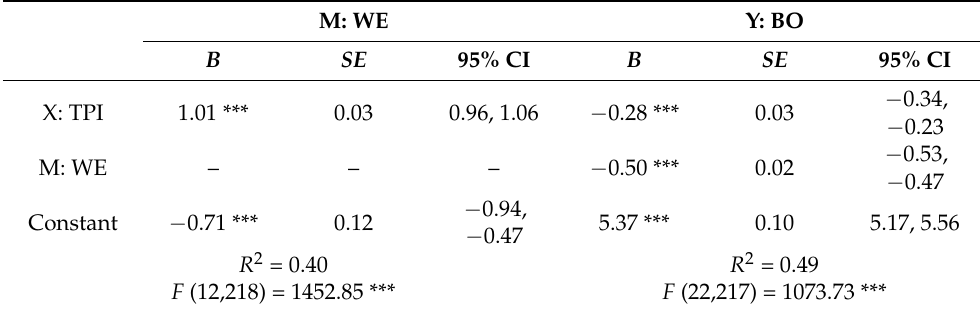
Table 2. Results of mediation analysis of work engagement.